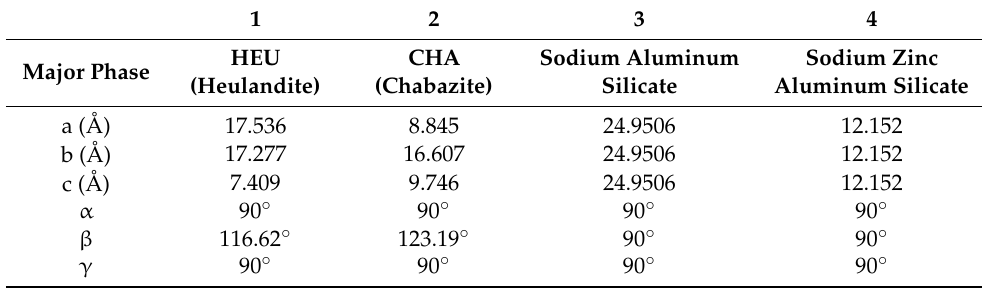
Table 4. The lattice parameters of zeolites before and after the adsorption of Zn 2+